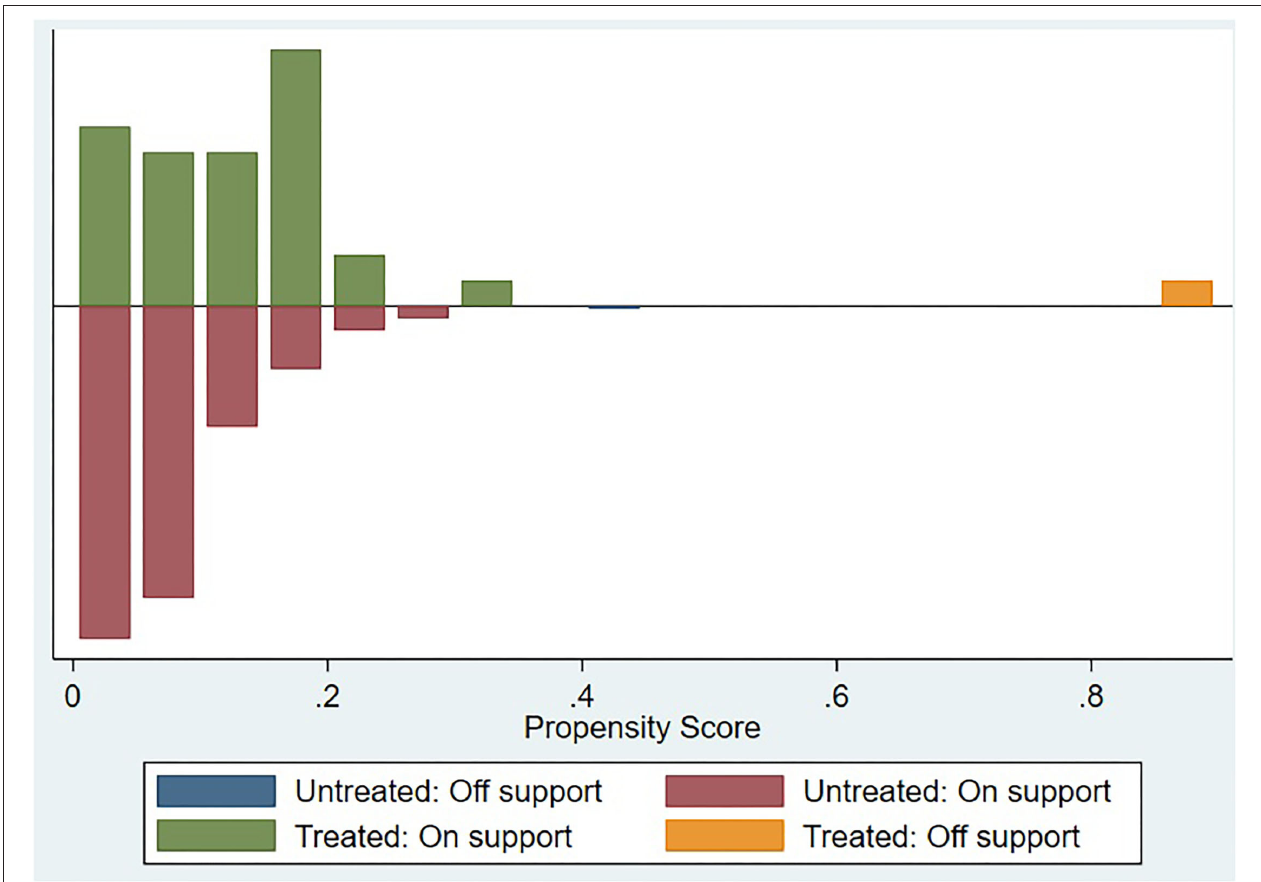
FIGURE 2 | Visual analysis of the validity of the common support